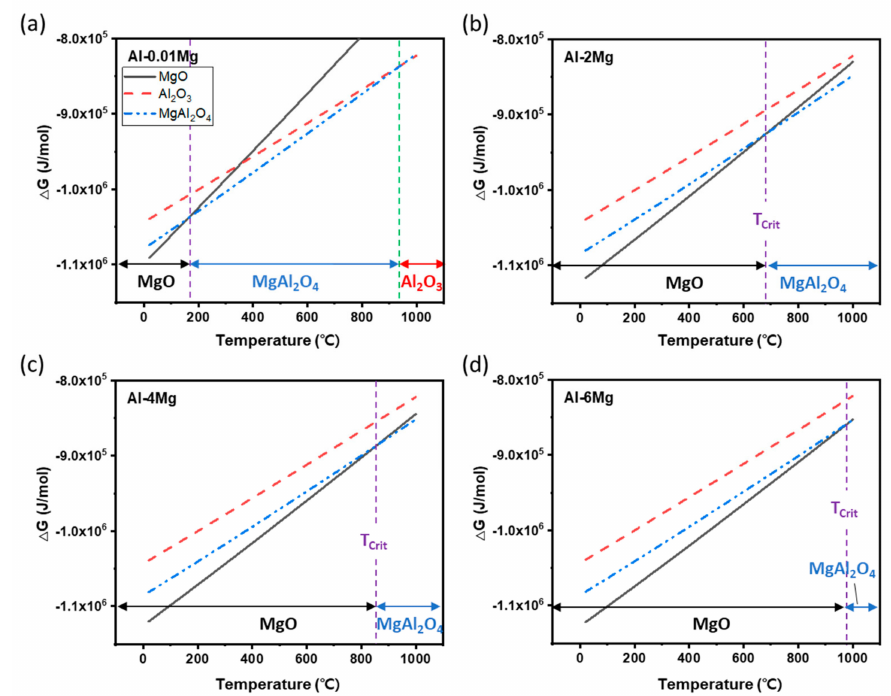
Figure 11. Gibbs free energy profiles of oxides Al 2 O 3 , MgAl 2 O 4 and MgO as a function of temperature in Al-Mg alloys; ( a ) Al-0.01Mg, ( b ) Al-2Mg, ( c ) Al-4Mg, and ( d )